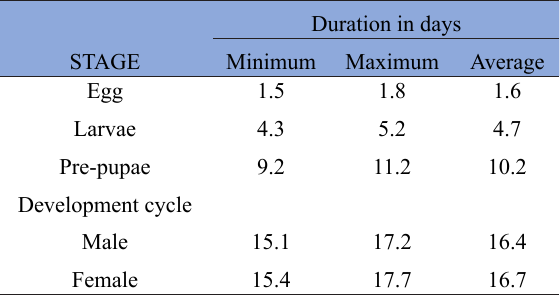
Table 1. Duration of the biological cycle of Prodiplosis longifila Gagné, under field conditions in the asparagus crop in the Chavimochic Irrigation Project.